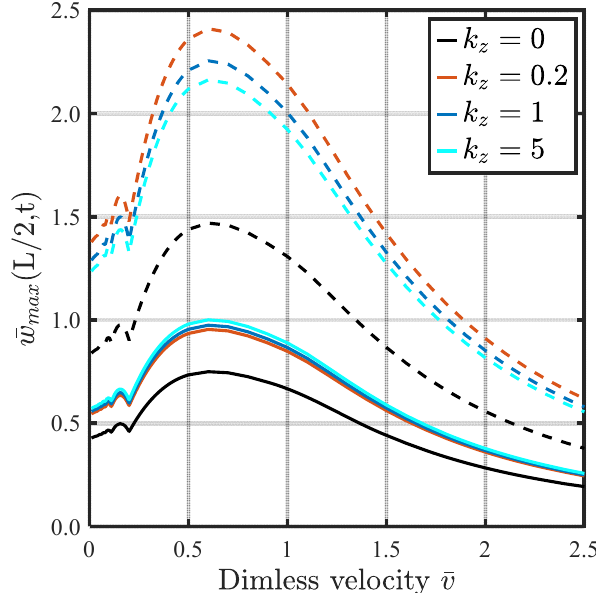
Figure 6. Influence of the transverse gradient index on the variation in the maximum normalized central dynamic deflection with the velocity ( k x = 0.2 ) ; (__) temperature-independent, (- -) temperature-dependent ( ∆ T = 80, LTR )